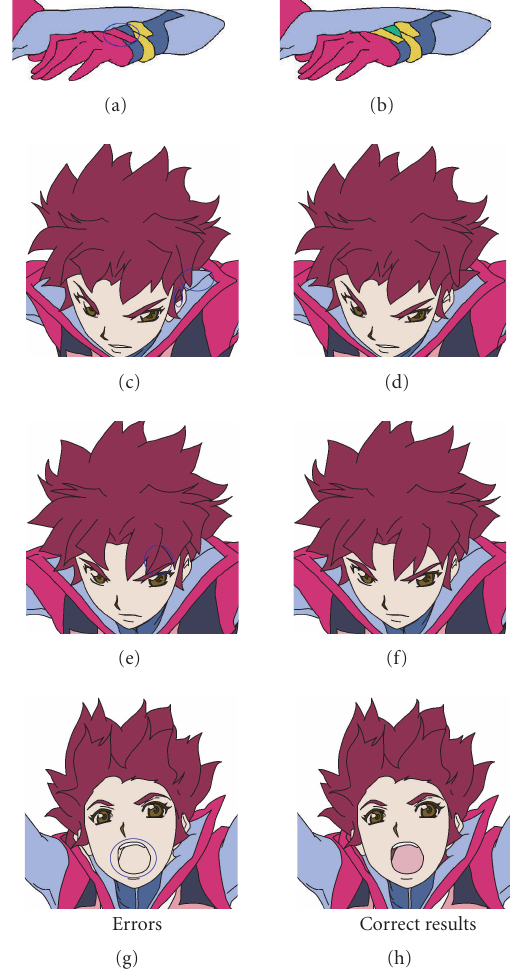
Figure 10: Error Analysis for Test 1.